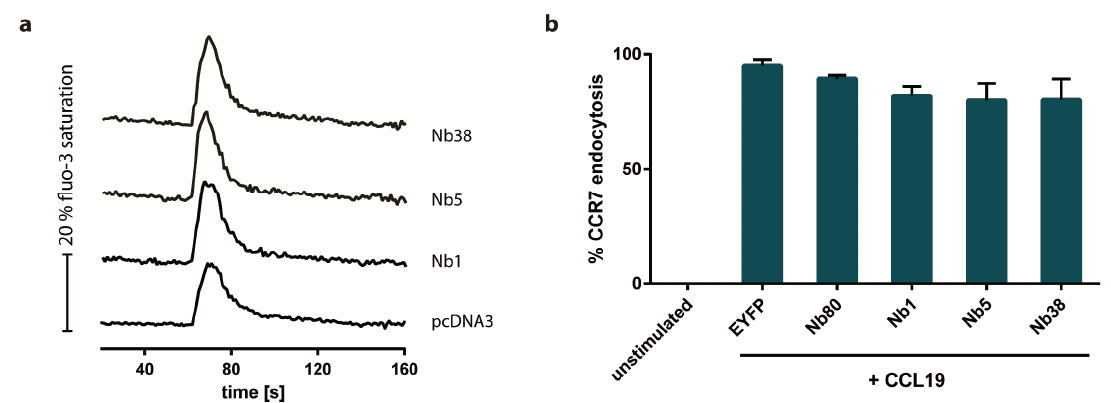
Figure 5. CCL19-mediated calcium mobilization and CCR7 endocytosis are not a ff ected by Nb1, Nb5, or Nb38. ( a ) Influence of intracellular expression of the CCR7-recognizing Nbs, Nb1, Nb5, and Nb38, on CCL19-mediated changes in intracellular calcium concentrations was measured in H1299 cells stably expressing CCR7-HA. Cells were stimulated with 0.5 µ g / mL of CCL19. A representative experiment out of three is shown. ( b ) Endocytosis of CCR7 triggered by 1 µ g / mL CCL19 was analyzed in HEK293-CCR7-HA cells transiently expressing CCR7-recognizing Nbs. Co-expressing EYFP or Nb80 instead of CCR7-recognizing Nbs served as controls. Mean values and SEM out of three independent experiments are presented.